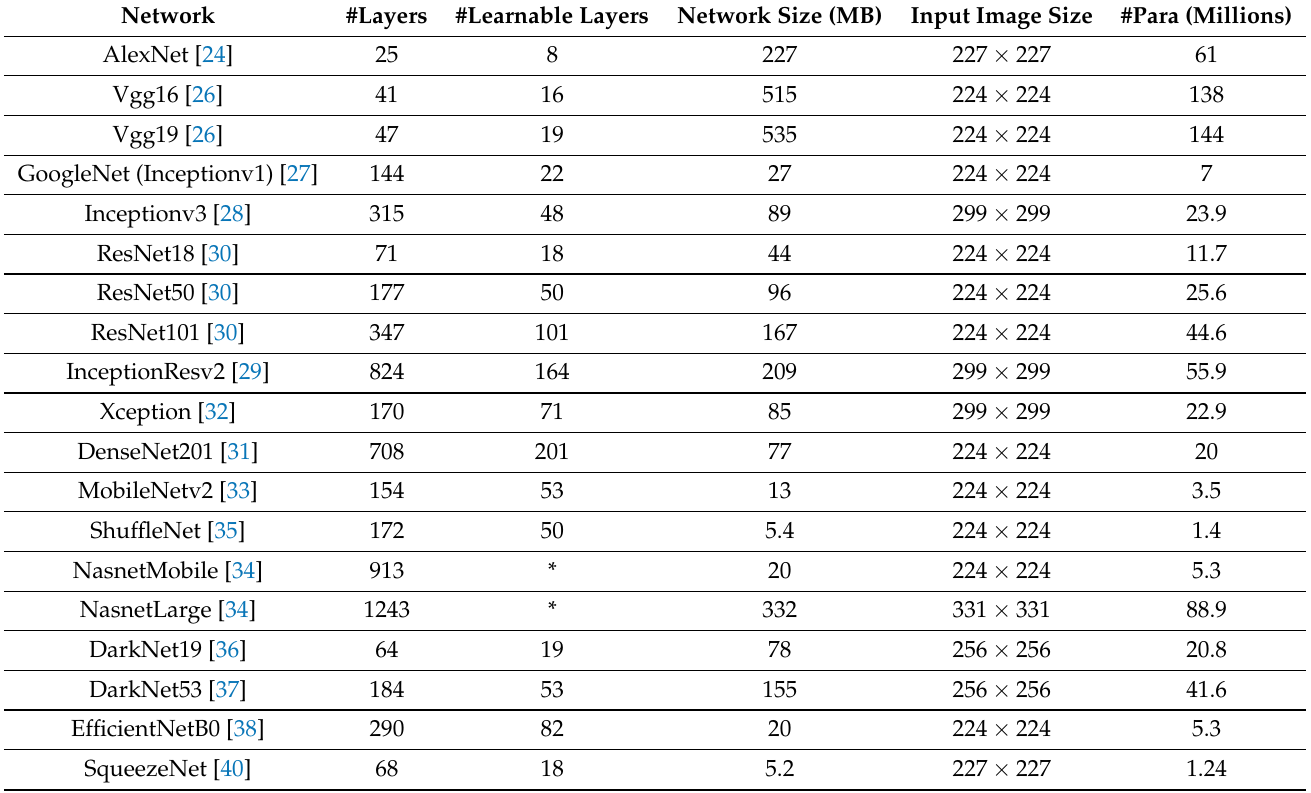
Table 1. Characteristics of the pre-trained CNN architectures adopted in our